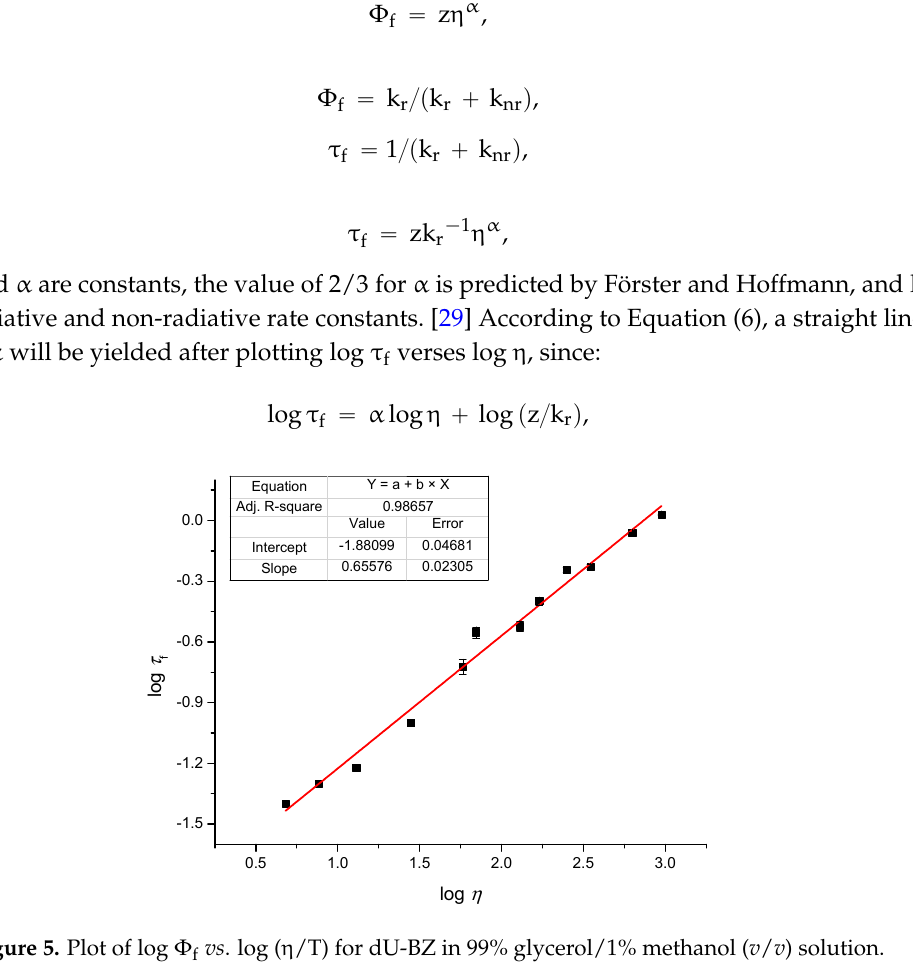
Figure 5. Plot of log Φ f vs . log ( η /T) for dU-BZ in 99% glycerol/1% methanol ( v / v ) solution.